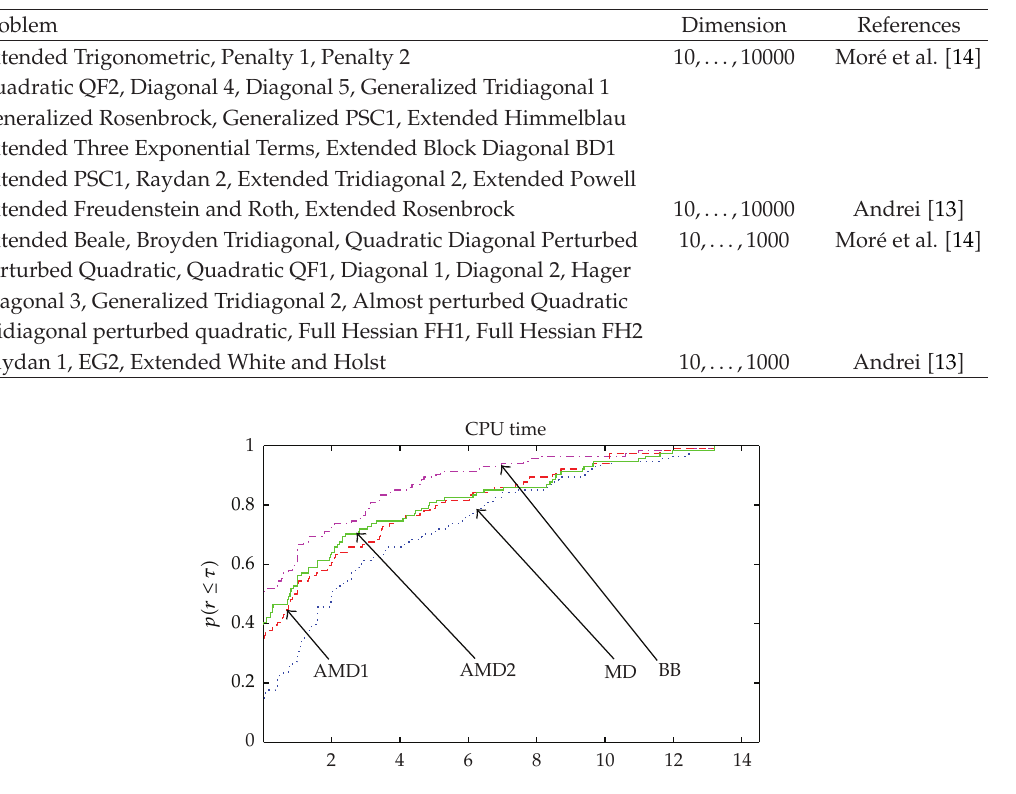
Figure 3: Performance profile based on CPU time per